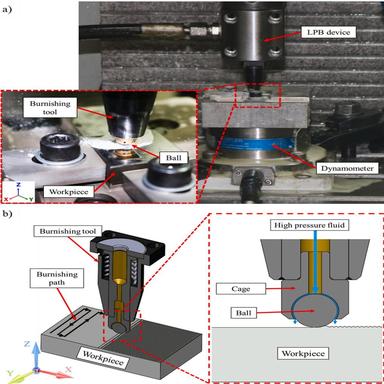
Low plasticity burnishing: (a) experimental setup and (b) working principle.